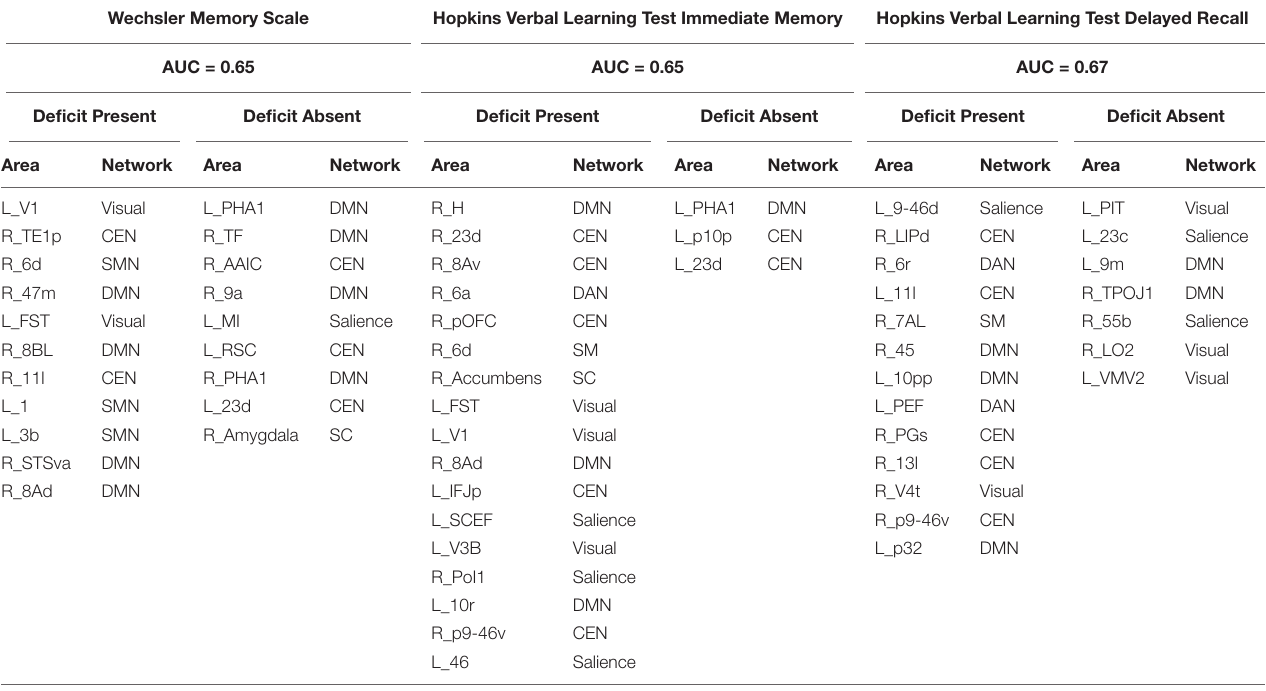
TABLE 2 | Predictors of performance in neuropsychiatric tests associated with verbal learning and memory. Wechsler Memory Scale Hopkins Verbal Learning Test Immediate Memory Hopkins Verbal Learning Test Delayed Recall AUC = 0.65 AUC = 0.65 AUC =